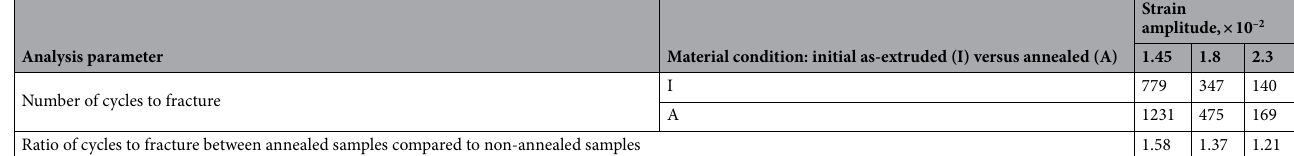
Material condition: initial as-extruded (I) versus annealed (A)